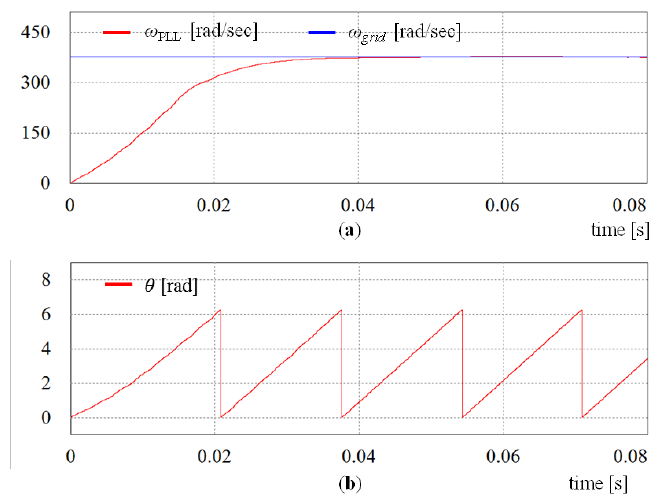
Figure 8. Dynamic response of the moving average filter phase lock loop (MAF-PLL) under the distorted grid voltages: ( a ) angular frequency; and ( b ) angular displacement.